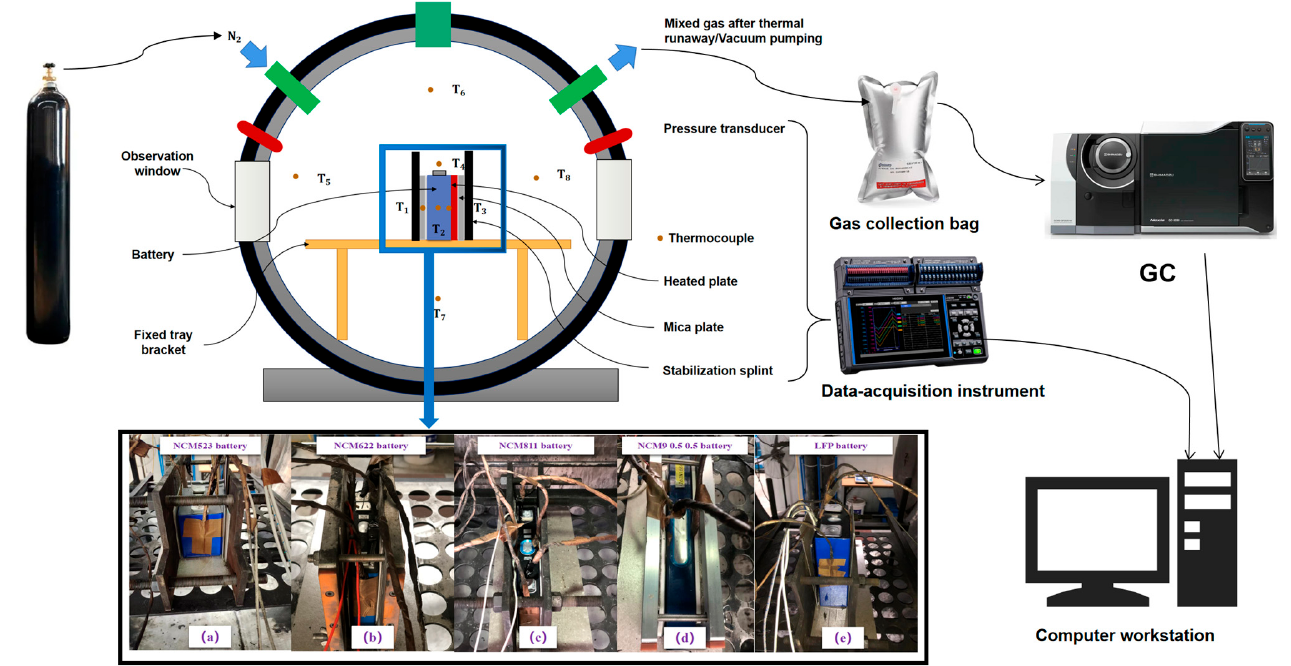
Figure 2. Experimental device structure diagram.